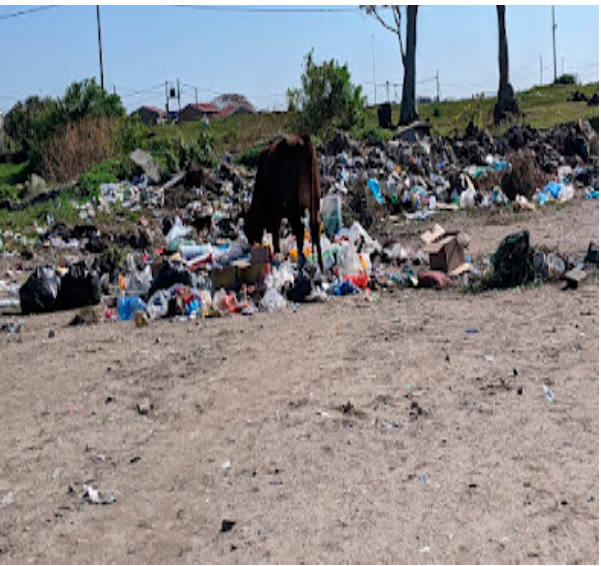
Figure 6. A cow seen churning away at plastic waste in a South African city (picture taken by author)